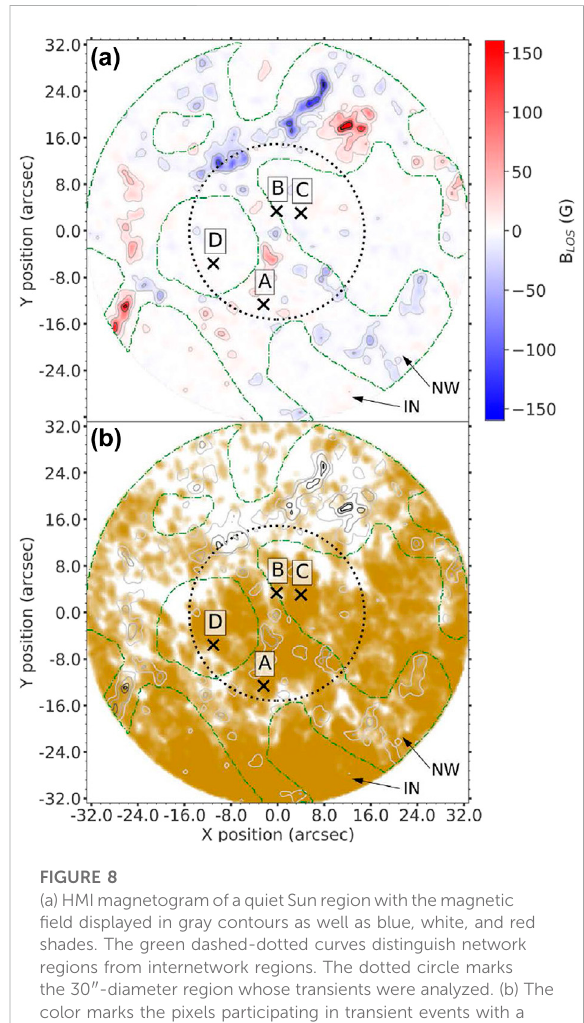
FIGURE 8 (a)HMImagnetogramofaquietSunregionwiththemagnetic fi eld displayed in gray contours as well as blue, white, and red shades. The green dashed-dotted curves distinguish network regions from internetwork regions. The dotted circle marks the 30 ″ -diameter region whose transients were analyzed. (b) The color marks the pixels participating in transient events with a brightness temperature > 400 K and duration shorter than 200 s. The contours have the same meaning as in panel (a) (from Eklund et al., 2020). Reproduced with permission ©